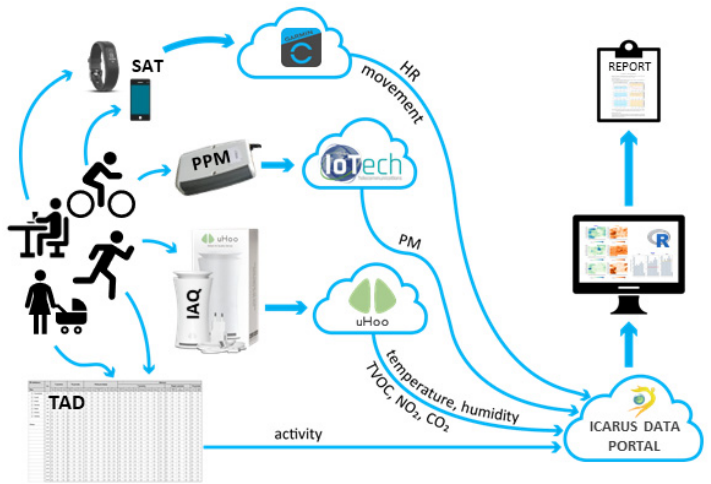
Figure 1. Schematic representation of data collection devices and protocols, transfer paths, aggrega- tion, visualization, and delivery protocols.